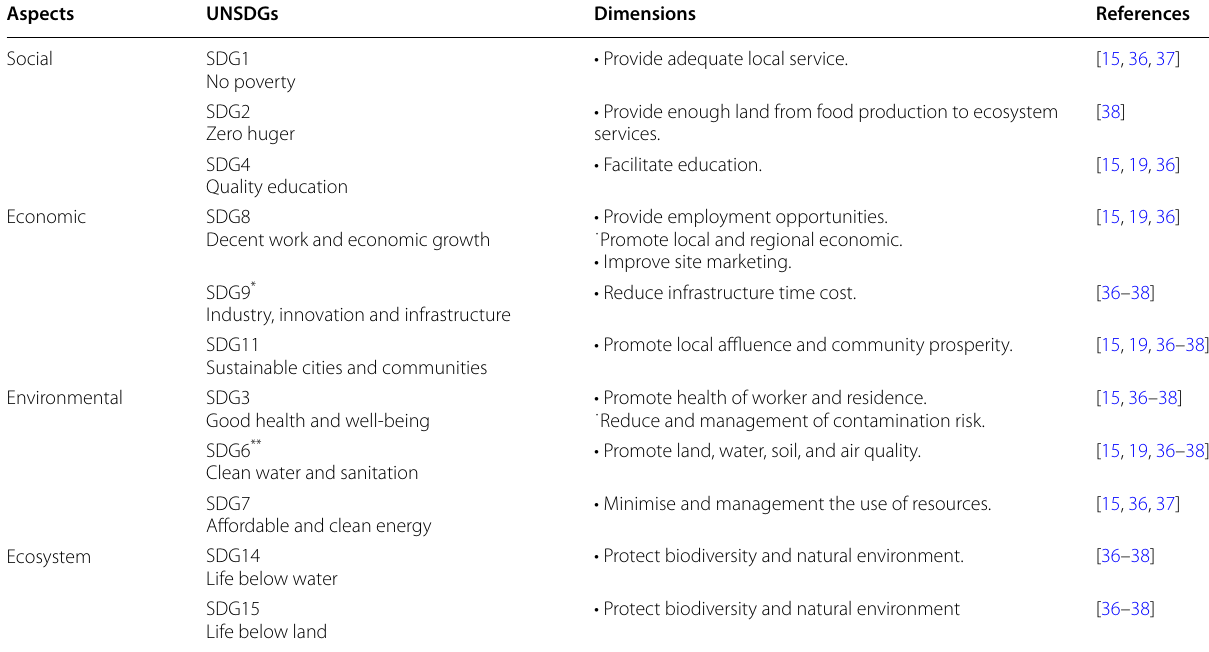
Note: * SDG9 indicates the affordable, safe, environmentally friendly, resilient and sustainable transportation in Taiwan, in which meaning is different with an asterisk of UNSGD ** SDG6 indicates the environmental quality and sustainable management of environmental resources in Taiwan, in which meaning is different with an asterisk of UNSGD